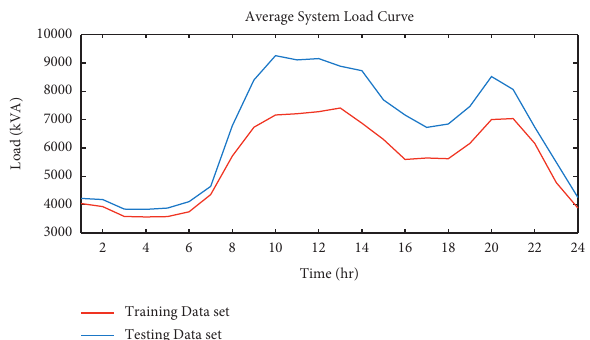
Figure 9: All events’ hourly average training and testing load data set of the system.